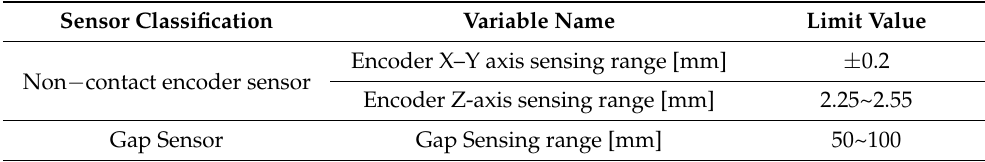
Figure 15. Restoration control algorithm to prevent derailment of magnetic levitation system (X-axis movement). Table 2. Sensing limit range specification of